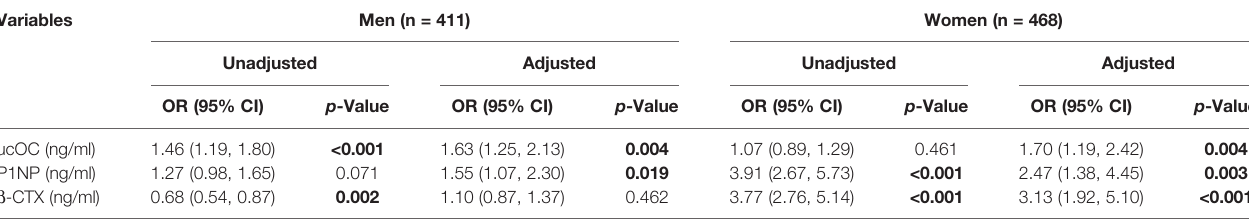
TABLE 4 | Odds ratio of prevalent osteopenia or osteoporosis according to a 1 − SD increase in ucOC and BTMs in the men and women.